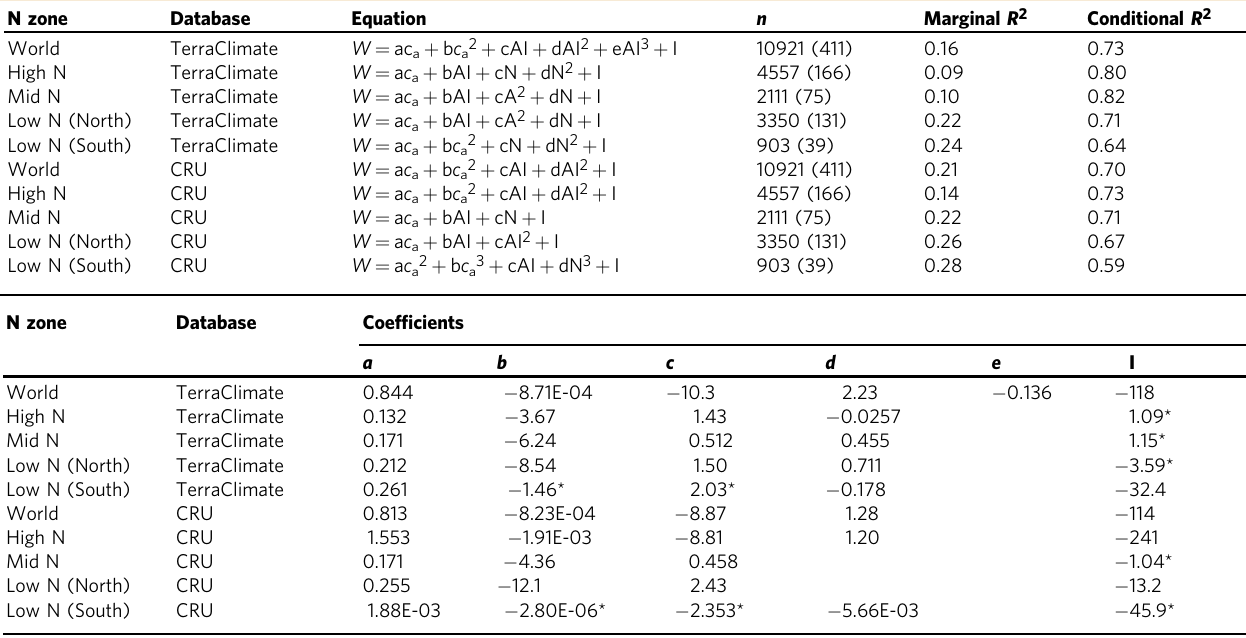
Table 2 Best- fi t multivariate analysis for W ( µ mol mol − 1 ) as a function of atmospheric [CO 2 ] ( c a , µ mol mol − 1 ), aridity index (AI = P/PET, dimensionless) and cumulative N deposition (N, gN m − 2 20 years − 1 ) as fi xed effects. N